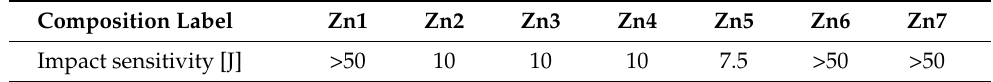
Table 2. Impact sensitivty of investigated Zn/KMnO 4 PDC formulations.